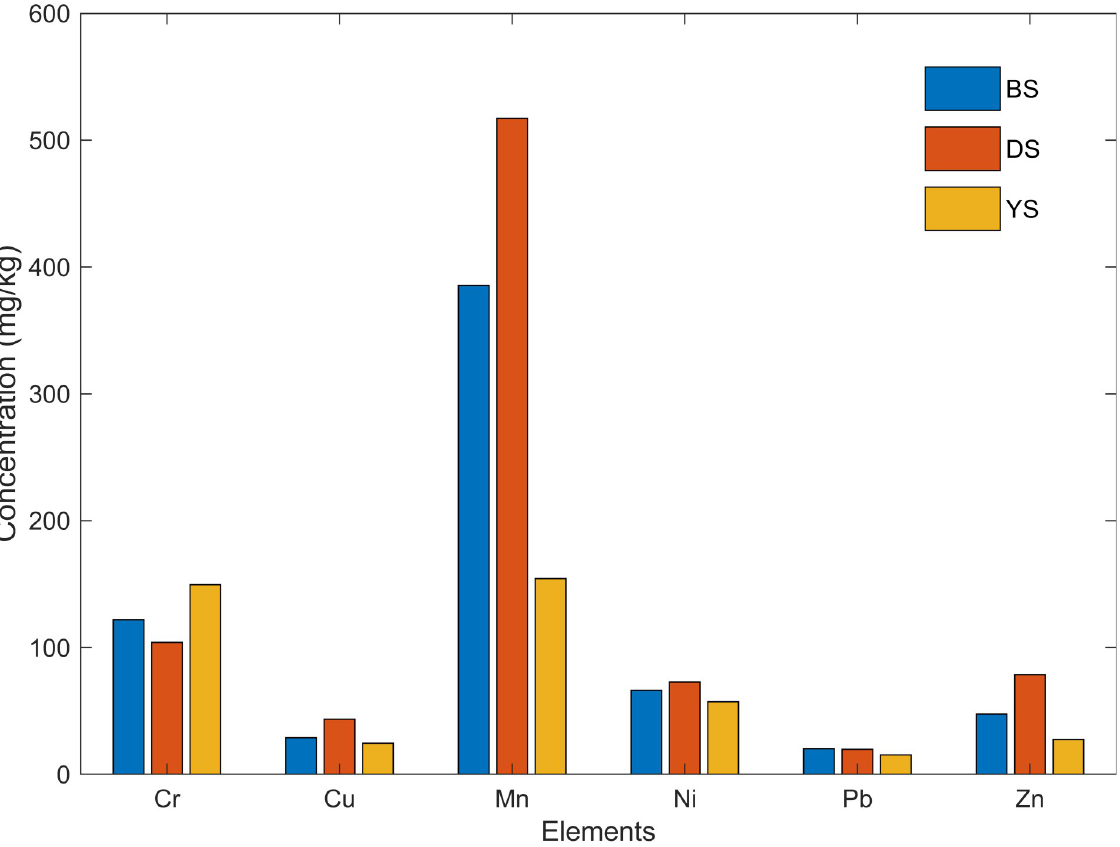
Fig 3. Comparison of elemental concentration in local soils: Badarpur sand, Delhi silt, and Yamuna sand.